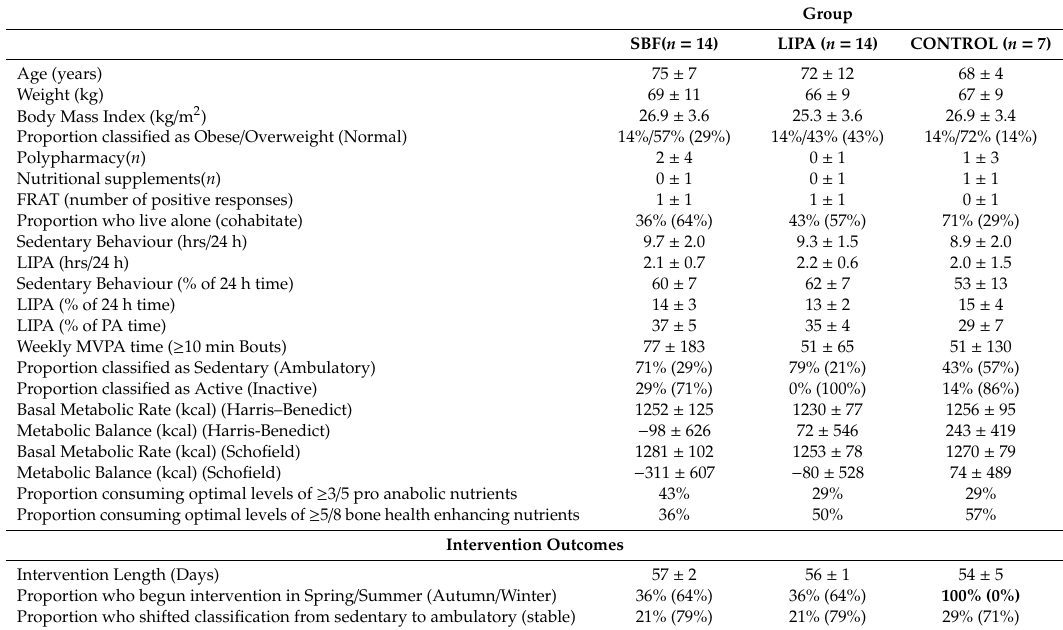
Table 1. Baseline measures based on